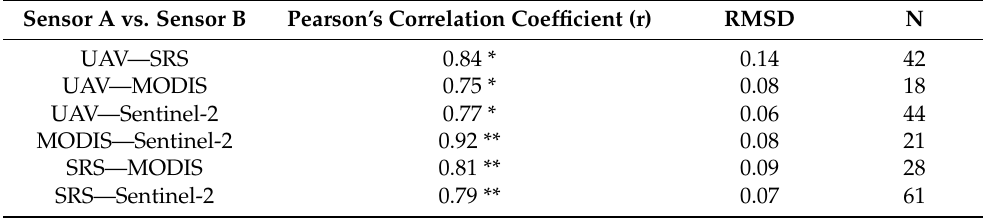
Table 4. Pearson’s correlation coefficient (r) and RMSD in NDVI units computed between UAVNDVI, SRSNDVI, MODISNDVI and Sentinel-2NDVI. N is sample size (total number of time series data).